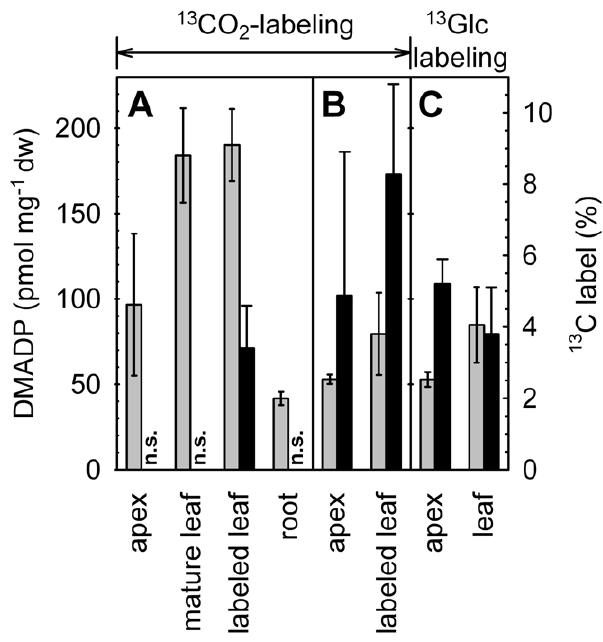
Figure 9. Concentration of the isoprene precursor DMADP and incorporation of 13 C in DMADP molecules in different plant parts of intact poplar plants and detached shoots. DMADP content (grey bars) and 13 C-incorporation into DMADP (black bars) in (A) apex, mature leaf, labeled leaf and root of intact plants labeled with 13 CO 13 CO 2 , in (B) apex and leaves of shoots labeled with 2 , and in (C) labeled with 13 Glc. Leaf DMADP content and relative 13 C-abundance (% of 13 C in total DMADP carbon) was assayed as described by Ghirardo et al. [10]. Data represent the mean of 3 experiments 6 s.d. (n.s.: no Figure 10. Tissue specific emission rates of BVOC from poplar significant 13 C-enrichment). plants. Summary of (A) methanol, (B) ethanol, (C) LOX products, (D) doi:10.1371/journal.pone.0017393.g009 acetaldehyde, (E) isoprene, (F) monoterpene, (G) total quantity of C loss as BVOC, average emissions during night (dark grey bars) and light (light grey bars) from (A) apex, (M) mature leaves younger than (L) labeled leaves, (R) root system in intact plants. The daily percentage of C loss (H) as BVOC related to daily net assimilation was calculated during day 2 (excluded for R). Data represent the mean of 3 experiments 6 s.e. (n.d. = not detectable). Statistical significant differences (t-test with p , 0.05) of emissions between A, M, L and R are given with different minuscule or capital letters for dark or light emissions,